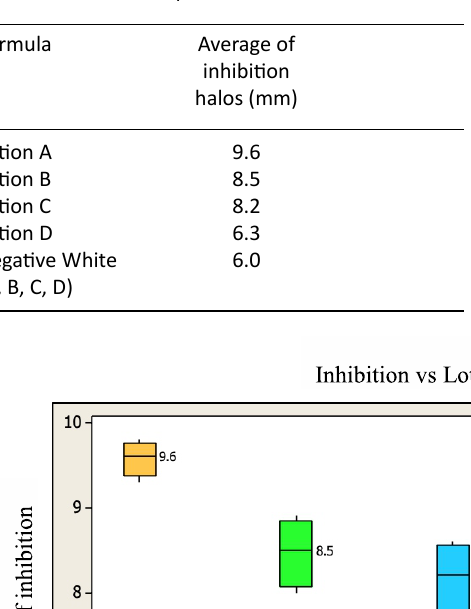
Table 4. Mean of inhibition halos (mm) of cosmetic formulas with L. acidophilus